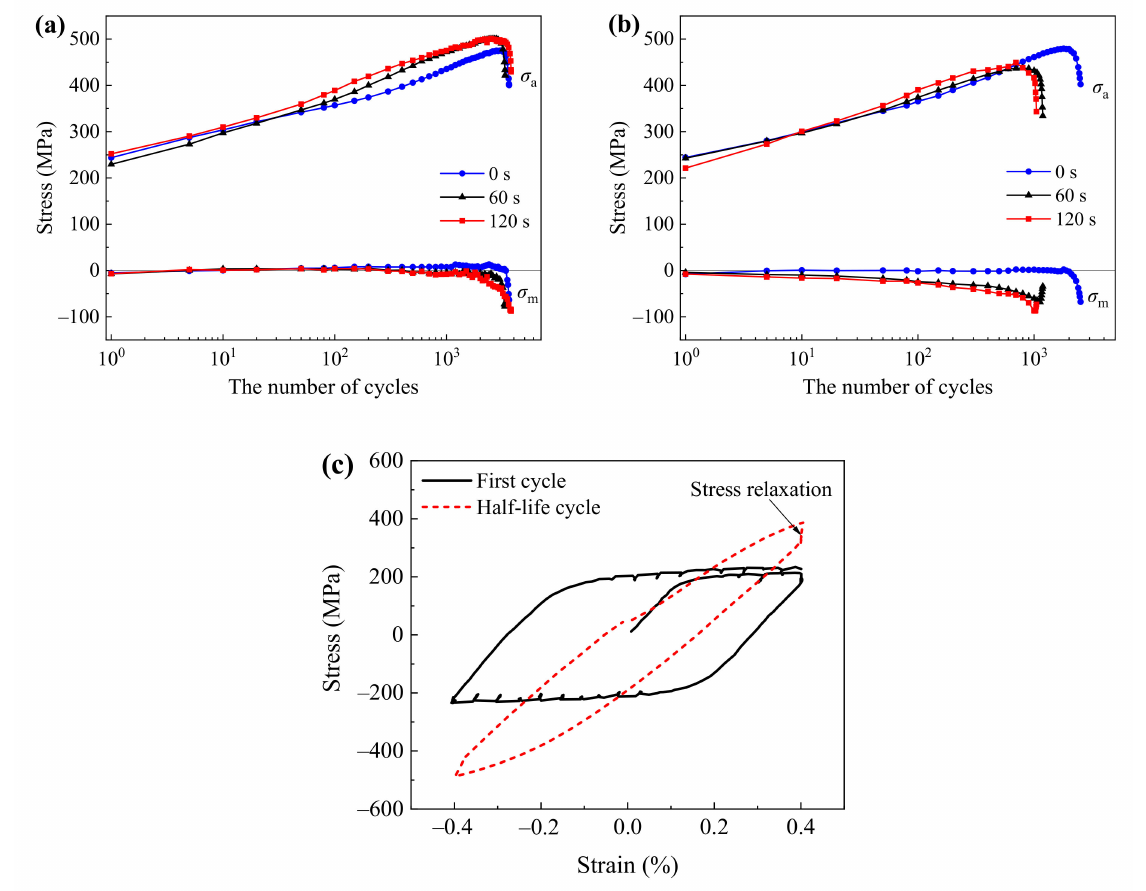
Figure 7. Cyclic stress response of the tests with different tensile-hold times at ( a ) 700 ◦ C and ( b ) 800 ◦ C, and ( c ) the hysteresis loops of C–F test ( t h = 120 s) at 800 ◦